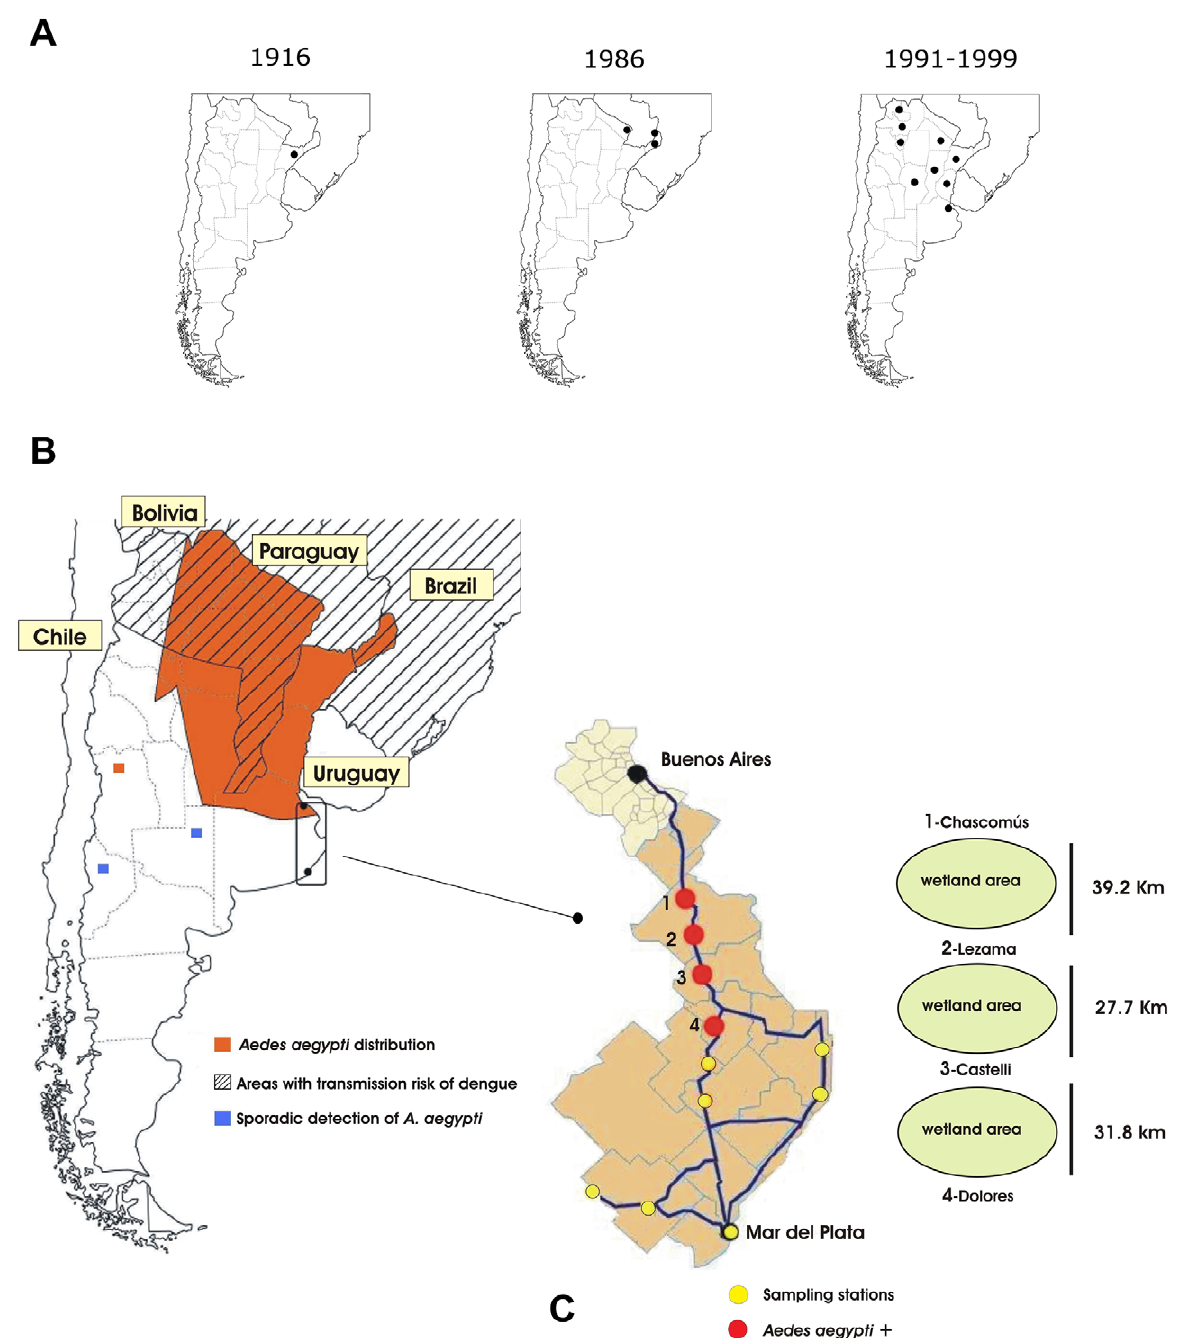
Figure 1. Aedesaegypti and dengue fever in South America. ( A ) Historical distribution of A. aegypti in Argentina, indicating 1916, the first dengue-like epidemic; 1986, re-infestation locations; and biogeographical records between 1991 and 1999. ( B ) Current geographic distribution of A. aegypti and regions with risk of transmission of dengue in South America. ( C ) Studied area, showing highways between Buenos Aires and Mar del Plata cities, sampling points, and distances between them. (A and B) adapted from Curto et al., Vezzani and Carbajo [10,15], and